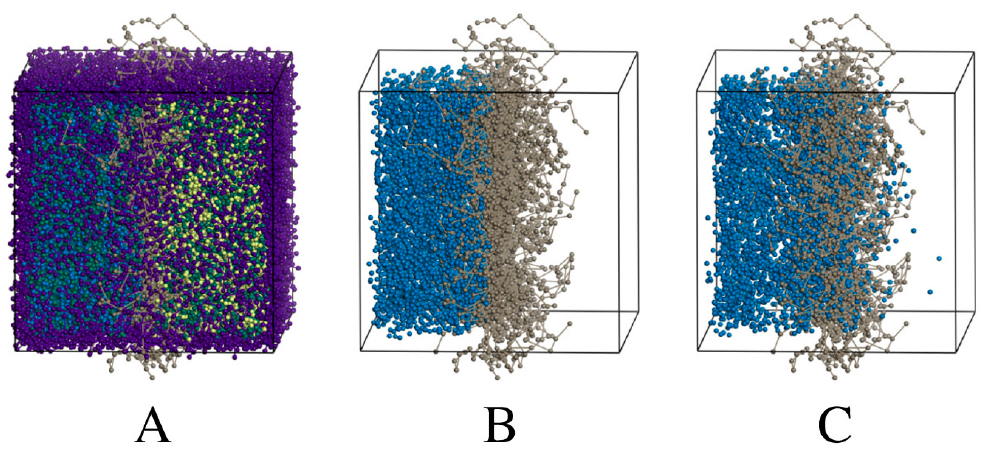
Figure 2. ( A ), the total simulation box containing neutral salicylic acid only with wall beads (purple), nitrocellulose (grey), salicylic acid (blue), water (green) and propylene glycol (yellow). Only nitrocellulose and salicylic acid beads are shown at different times as multiples of τ during the trajectory simulation; ( B ) 1 τ , ( C ) 75,000 τ , ( D ) 250,000 τ , ( E ) 500,000 τ , ( F ) 1,000,000 τ .